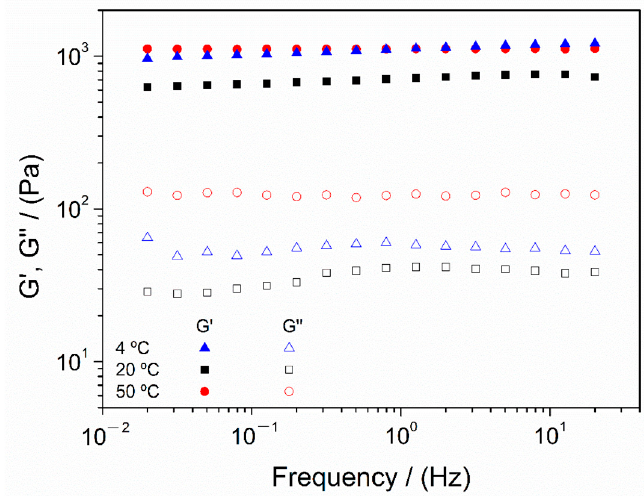
Figure 4. Frequency sweep tests of chitosan hydrogels processed at different gelation temperatures (4, 20 and 50 °C). The presented data are the mean values for each system. Table 3. Strain and frequency sweep tests parameters (mean value + standard deviation) for chi- tosan hydrogels processed at different gelation temperatures (4, 20 and 50 °C). G’ 1 : elastic modulus at 1 Hz; tan δ 1 : loss tangent at 1 Hz; η * 1 : complex viscosity at 1 Hz.